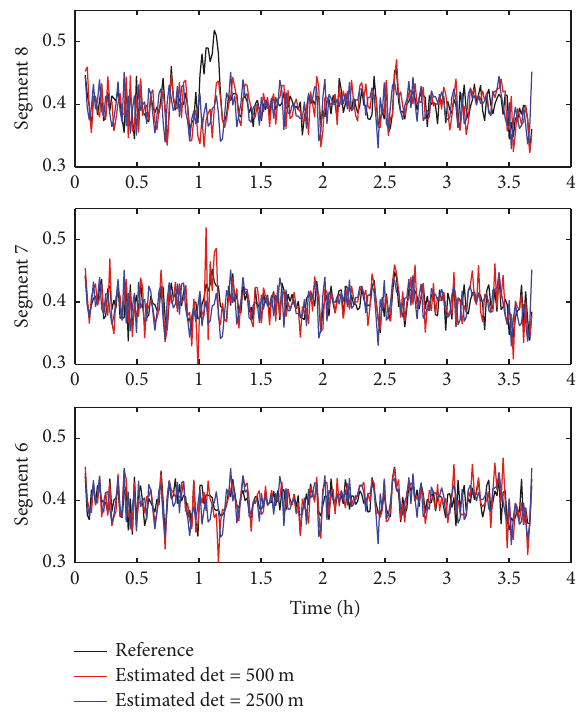
Figure 8: The reference (black) and the estimated penetration rate for segments 6–8 with a detector distance of 500 meters (red) and 2500 meters